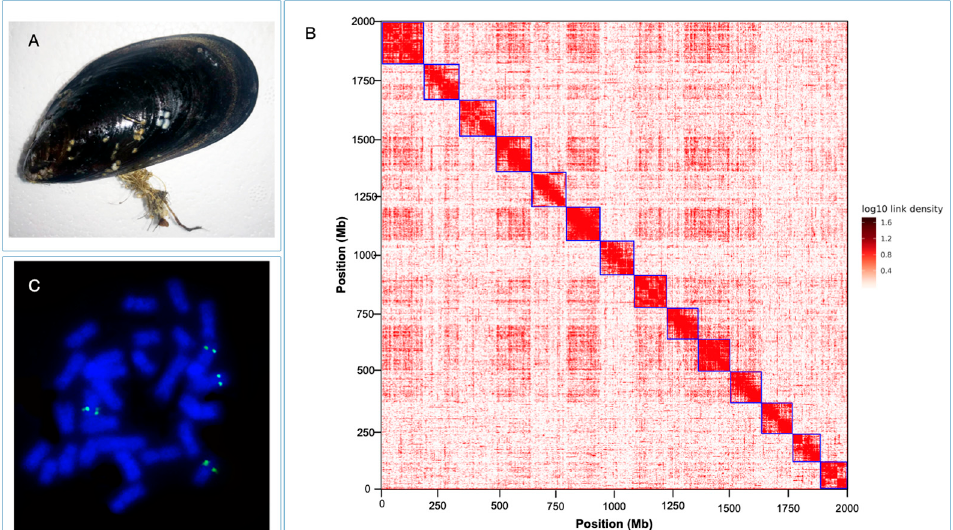
Figure 1. ( A ) Photograph of the native blue mussel Mytilus chilensis . ( B ) Metaphasic chromosomes from mussel larvae samples and mapping of 28S-rDNA by fl uorescence in situ hybridization. ( C ) Heatmap of chromosome interaction intensity in the blue mussel Hi-C assembly. The x - and y -axis represent the length of the chromosomes. The color bar represents the Hi-C contact density.